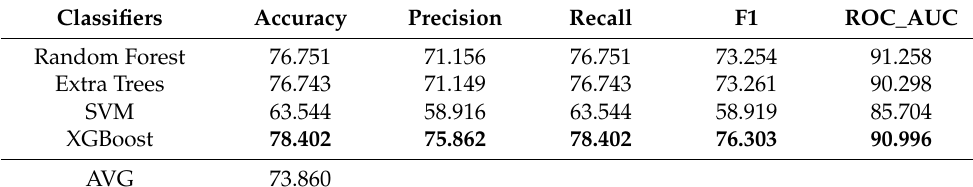
Table 5. Experimental Results using S_DNA with 1085